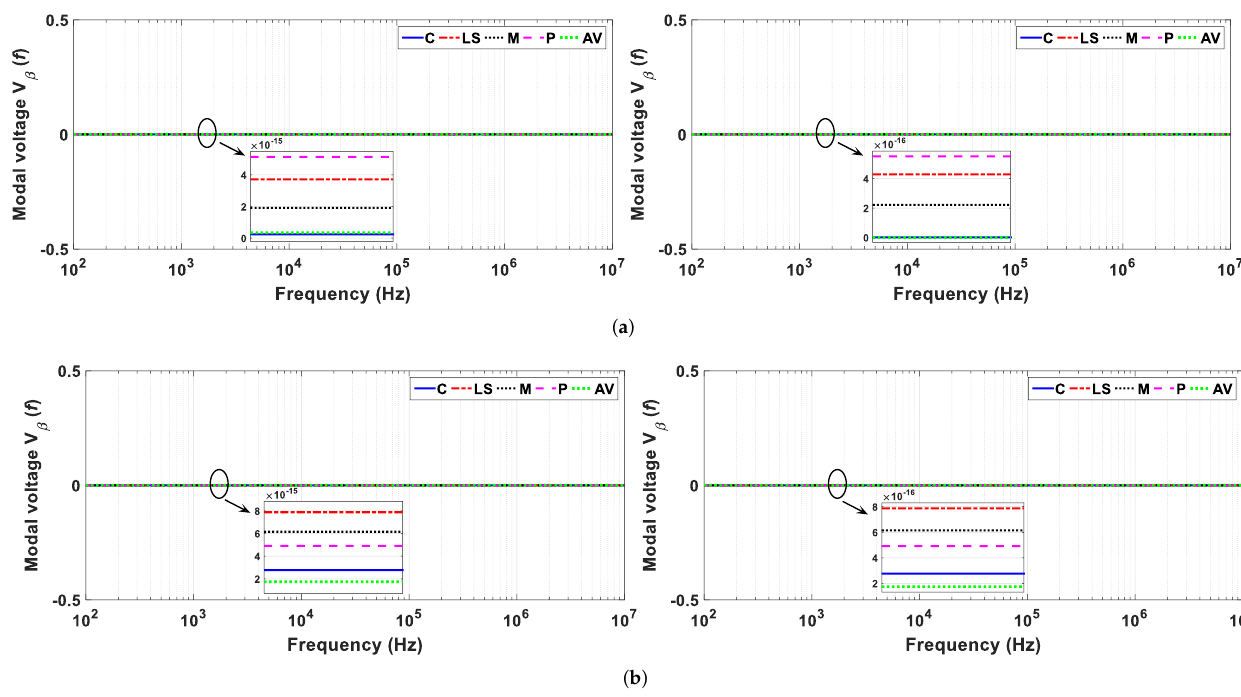
Figure 16. Transient voltages at the receiving end of mode β obtained for the lightning direct strike for the 1 km OHTL ( left ) and 10 km OHTL ( right ) with ρ 0 of: ( a ) 700 Ω · m and ( b ) 4000 Ω